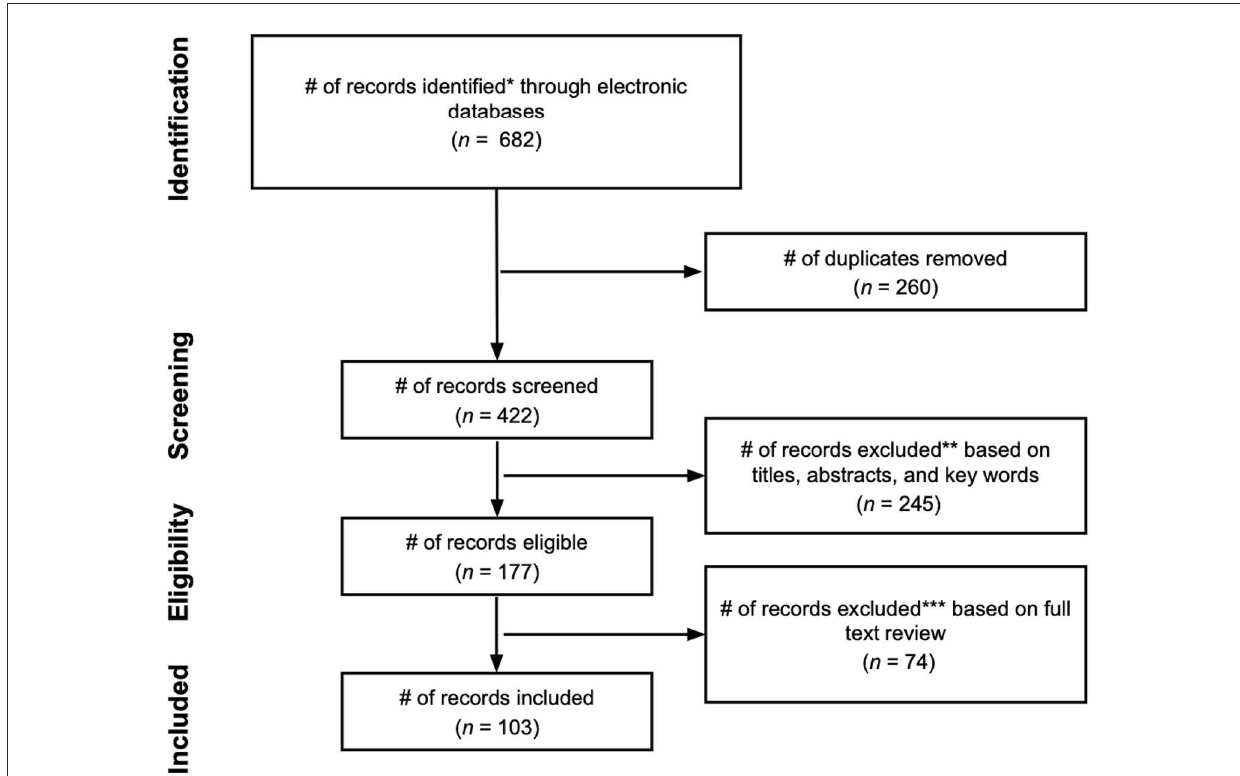
FIGURE1 Search and identification process for included studies. * Boolean search methods were used to identify the studies (e.g., [autis * or ASD or asperger * or pervasive develop * ] and [biling * or multiling * or “language learner * ” or “second language”]). ** Papers needed to include bilingual and/or autistic samples. *** See “Search strategy and study selection” for a thorough description of the inclusion and exclusion criteria.